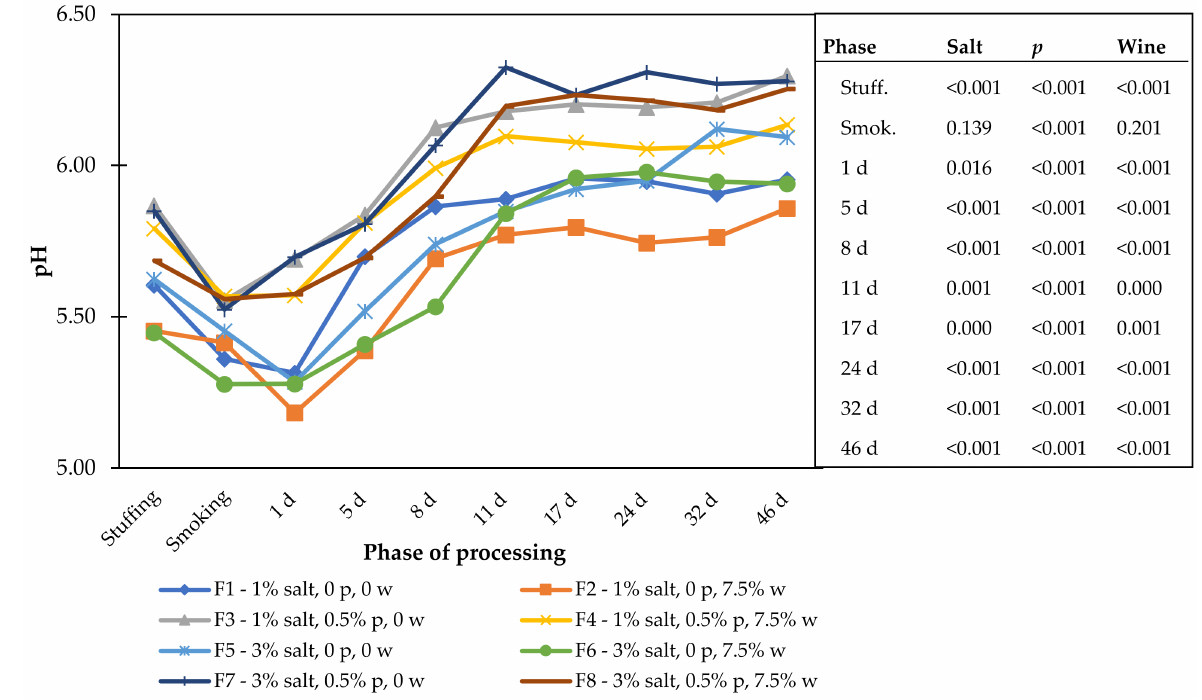
Figure 1. pH in cured sausages with different formulations during processing (p—phosphate;